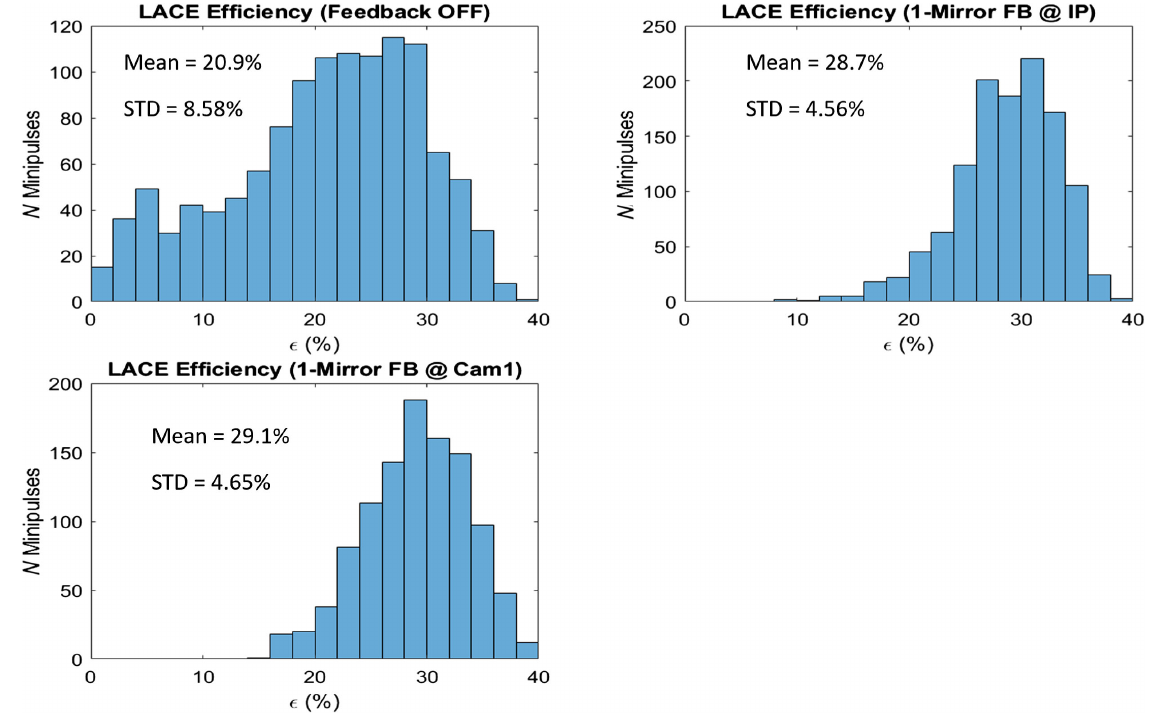
aligned.FIG. 12. A histogram of the stripping efficiency in the single-step excitation experiment for different conditions of the laser positioning feedback. Top left: The feedback is off. Top right: The feedback is on but not optimized. Bottom left: All parameters are optimally